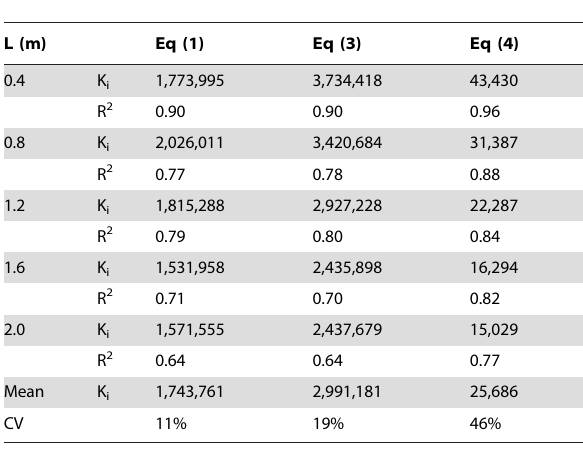
Table 1. Interrill erodibilities ( K i ) and coefficients of determination ( R 2 ) for Eqs (1), (3) and (4) for different slope